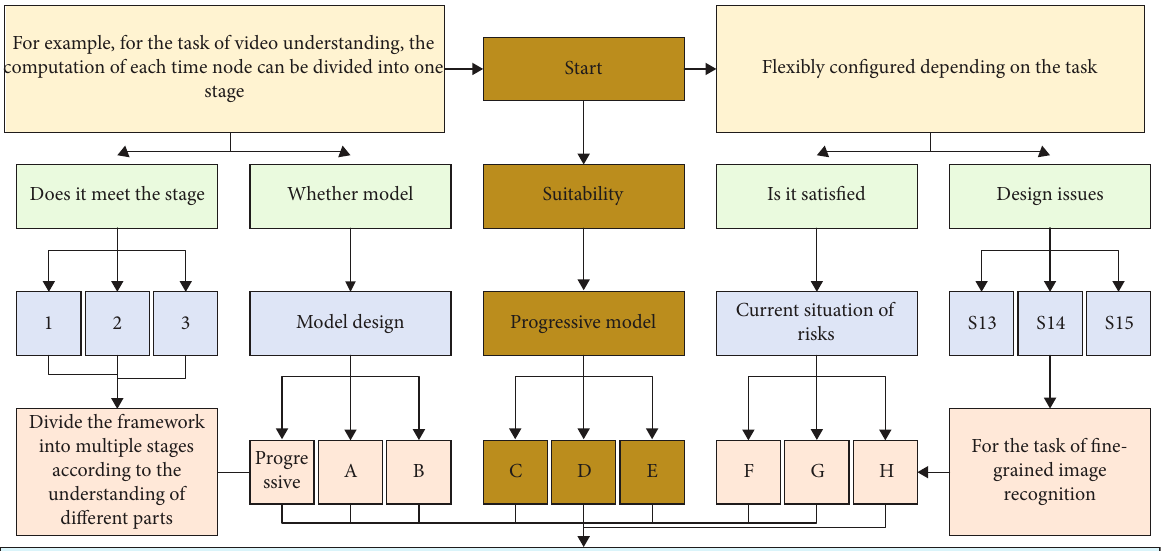
Figure 3: Progressive learning research